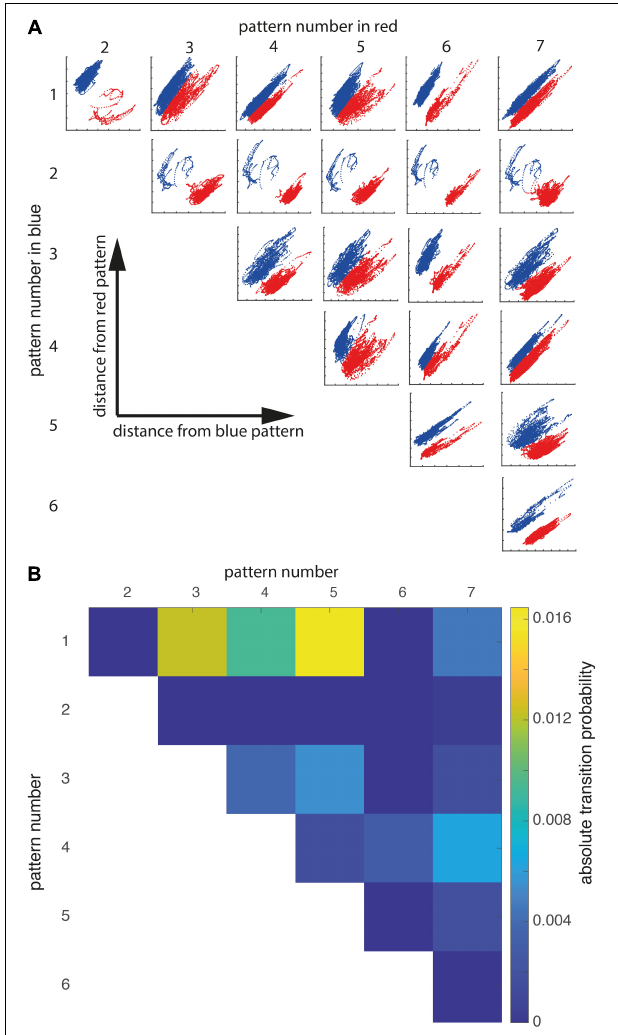
FIGURE 3 | State transitions are continuous and specific. (A) Pairwise plots showing how k-means clustering separated the dynamic covariance matrices into patterns. The blue pattern number is given in the left-side column, the red pattern number is in the top row. The x-axis gives the distance from the blue pattern, while the y-axis gives the distance from the red pattern. For example, the top left plot shows covariance matrices classified as pattern 2 in red and covariance matrices classified as pattern 1 in blue. The x-coordinate of a given data point is the distance from pattern 1, whereas the y-coordinate is given by distance from pattern 2. Units are omitted since they are arbitrary. (B) Matrix showing the absolute transition probability from pattern X (top row) to Y (left-sided column) or vice